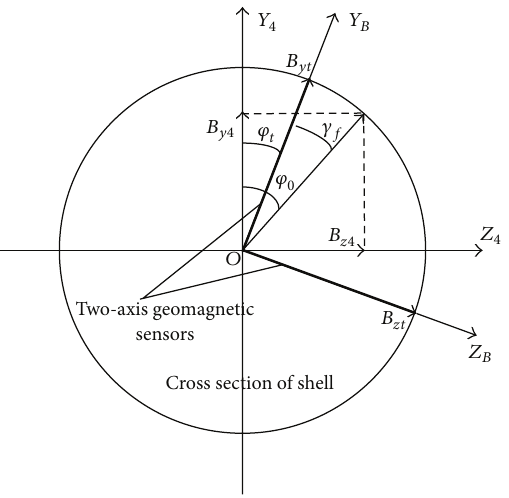
Figure 17: Relationship between the geomagnetic sensors and the components of geomagnetic field in the quasi body reference frame.